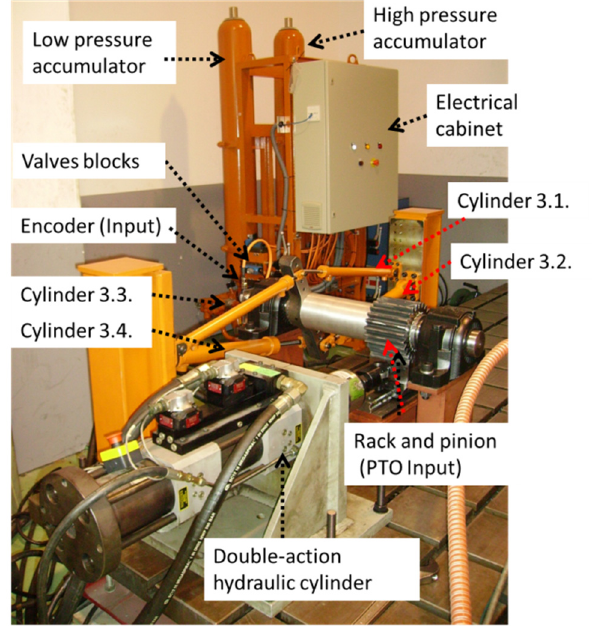
Figure 20. Hydraulic PTO. Main elements of the Test bench. PTO Input.